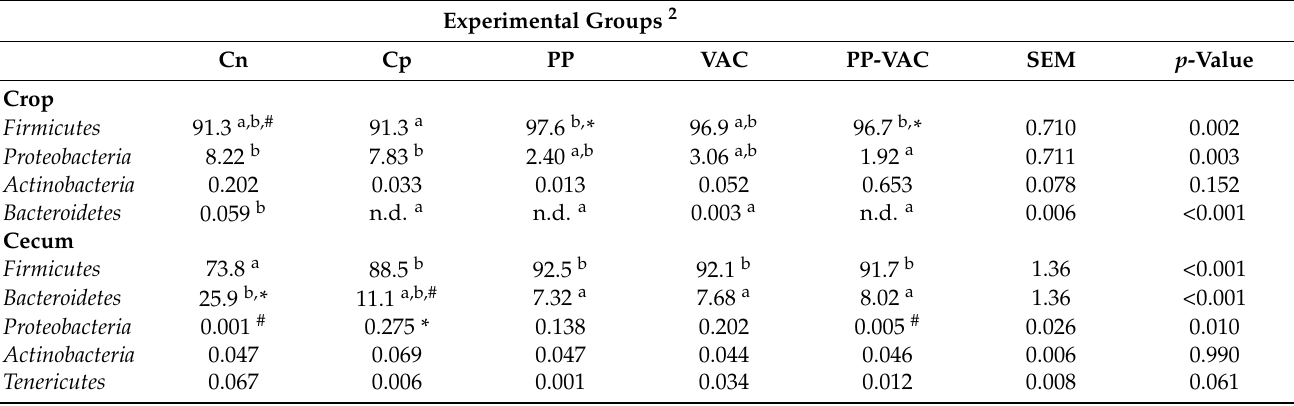
Table 3. Impact of parent stock vaccination and dietary pre-and probiotic combination on relative abundance (%) 1 of bacterial phyla in crop and cecal digesta of 28-day-old Ross 308 broilers challenged with E. coli O1/O18 on day eight of